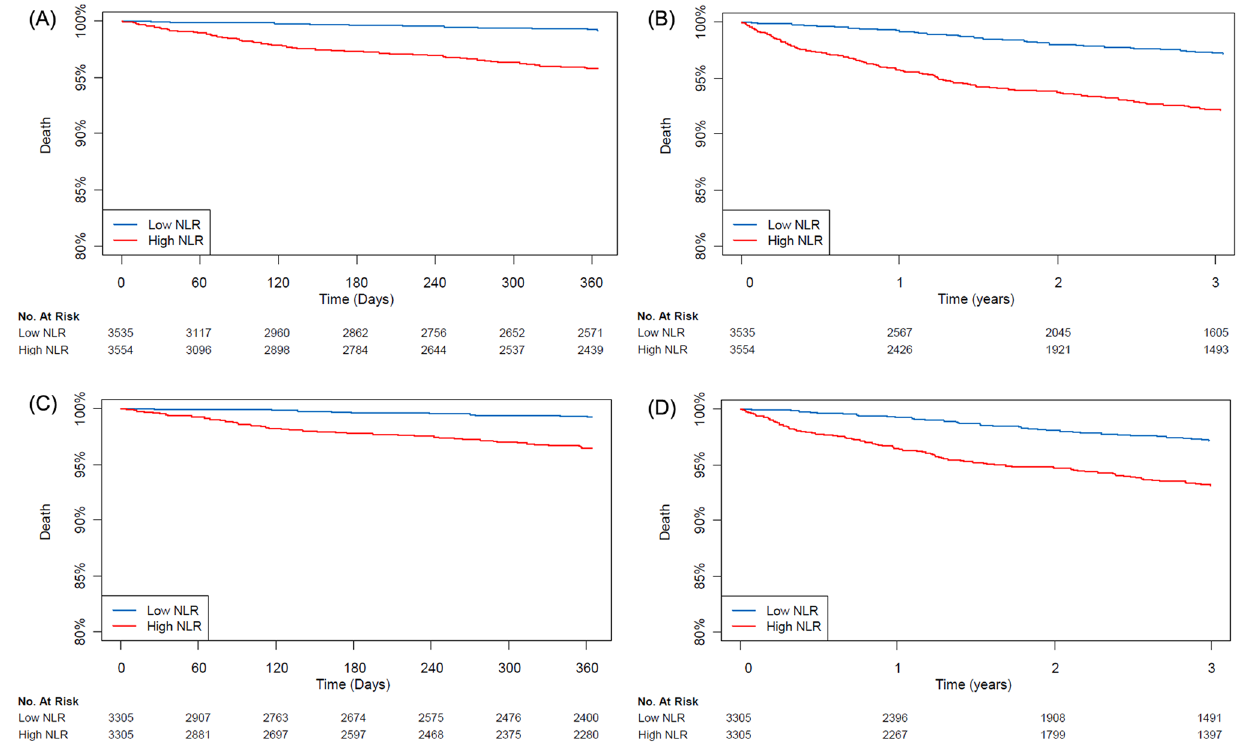
Figure 1. Kaplan Meier curves of the groups divided by median value for mortality in the entire population during ( A ) 1-year and ( B ) overall follow-up periods, and propensity matched population during ( C ) 1-year and ( D ) overall follow-up periods.